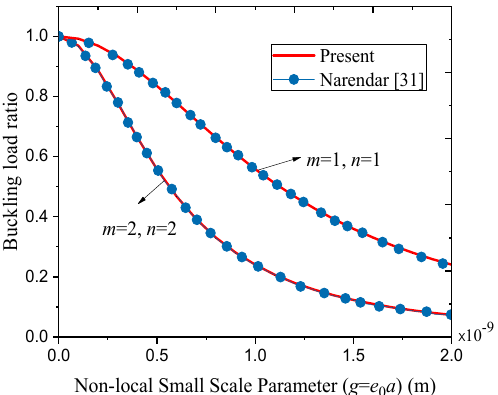
Figure 3. Variation of buckling load ratio with a non-local small-scale parameter for a square homogeneous nanoplate ( a = b = 5 nm).